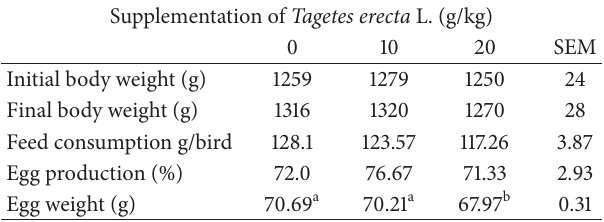
Table 4: The effects of Tagetes erecta L. supplementation on the fatty acid composition of egg yolks 1